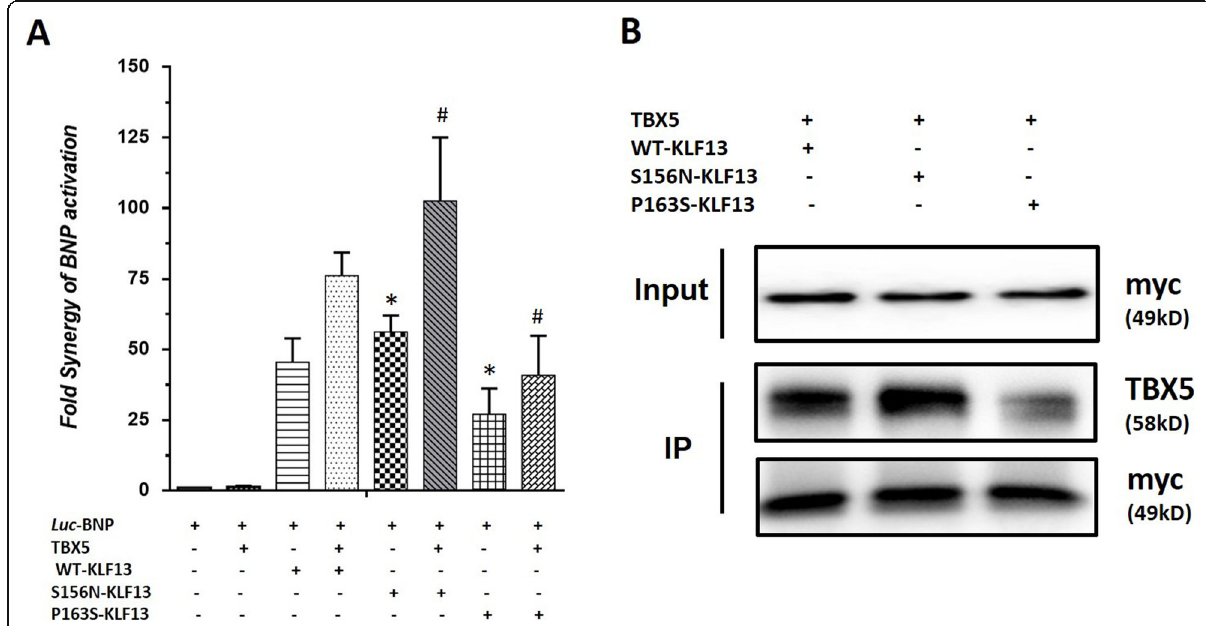
Fig. 3 KLF13 variants have effects on genetic interaction with TBX5. a : Luciferase activity in NIH3T3 cells cotransfected with wild-type KLF13 or mutant-expression constructs and the BNP promoter, showing that the P163S mutant could decrease the synergistic activation of the BNP promoter, while the S156N mutant increased the synergistic activation of BNP . b : Coimmunoprecipitations were carried out using 293 T cells expressing Myc-KLF13 and TBX5 proteins in combination. The top panel shows Western blots of the nuclear extracts used, with the indicated antibodies. The bottom panel is a Western blot of the anti-TBX5 immunoprecipitates. (* p < 0.05, Statistical significant vs WT, # p < 0.05, Statistical significant vs WT co-transfected with